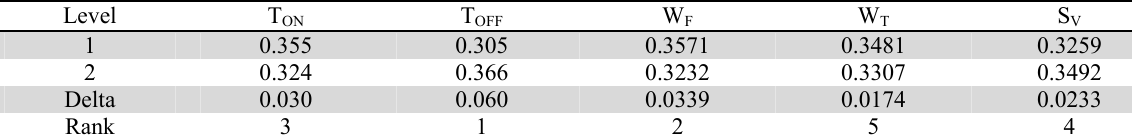
Response table for TQL